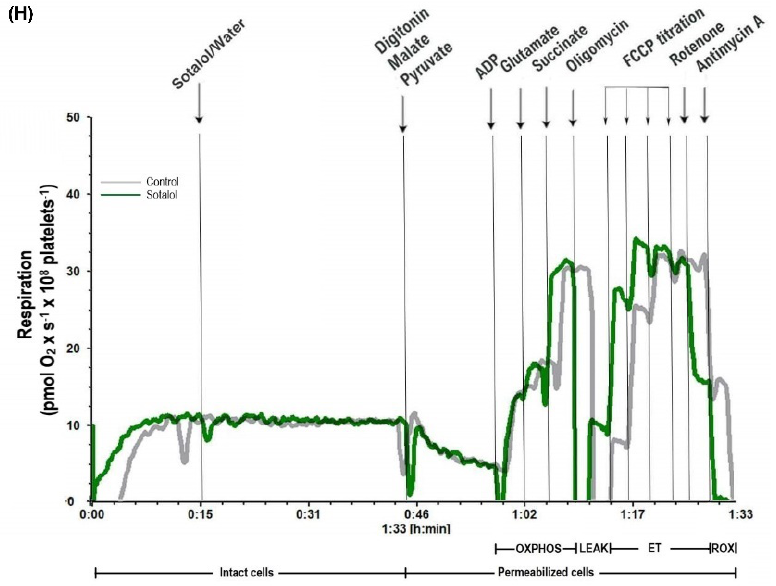
Figure 2. Amiodarone (but not sotalol) induced a concentration-dependent inhibition of mitochondrial respiration in permeabilized platelets. ( A ) Representative trace of amiodarone-induced mitochondrial dysfunction (amiodarone-red; DMSO/solvent-grey). Concentration-dependent effects were assessed for 3 doses (60 µ M, 120 µ M and 240 µ M) of amiodarone (red rhombus) and sotalol (green square), respectively. P-L control efficiency, a measure of ATP generating respiration ( B ), LEAK ( C ), E-L coupling efficiency, a measure of ATP generating respiration ( D ), ET capacity ( E ), maximum OXPHOS ( F ), NADH-linked OXPHOS ( G ) were evaluated. ( H ) Representative trace of sotalol effects (sotalol-green; H 2 O/solvent-grey). Data were expressed as mean ± SEM of the percent of control (platelets exposed to the corresponding volume of DMSO and H 2 O for highest concentration of drug). Two-way ANOVA with Bonferroni post hoc test was performed on the antimycin-corrected data. DMSO: dimethyl sulfoxide. ADP: adenosine diphosphate. FCCP: carbonyl cyanide p-(trifluoromethoxy) phenylhydrazone. OXPHOS: oxidative phosphorylation. LEAK: non-phosphorylating respiration. ET: electron transfer. ROX: residual oxygen consumption. * p < 0.05, ** p < 0.01 vs. control. n = 5.